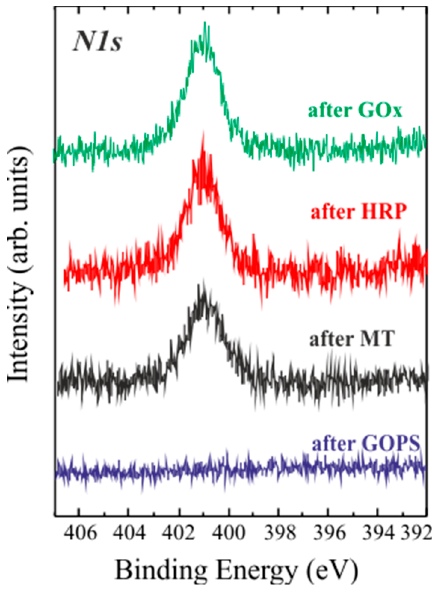
Figure 2. XPS N1s spectral regions of the samples after the various GOPS derivatization steps: after GOPS ( blue line ) addition; after binding of GOx ( green line ); HRP ( red line ) and MT ( black line ).